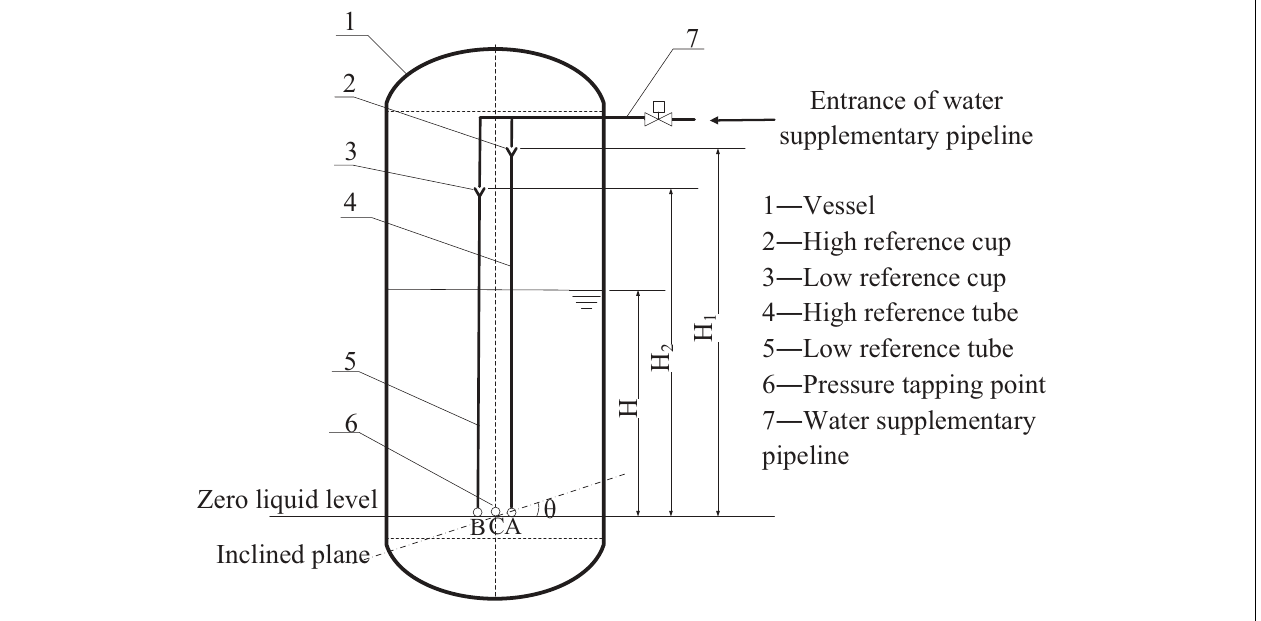
FIGURE 1 | Structure diagram of level measurement